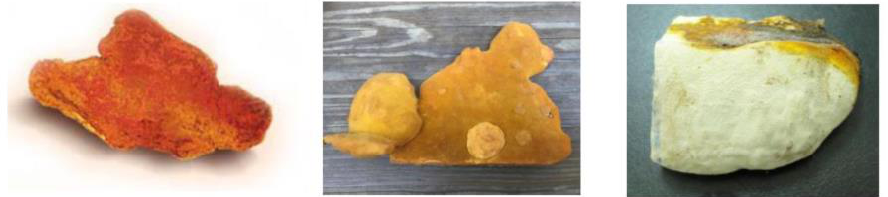
Figure 1. The appearance of fruiting bodies of different A. cinnamomea phenotypes. The images from left to right are red AC, yellow AC, and white AC.